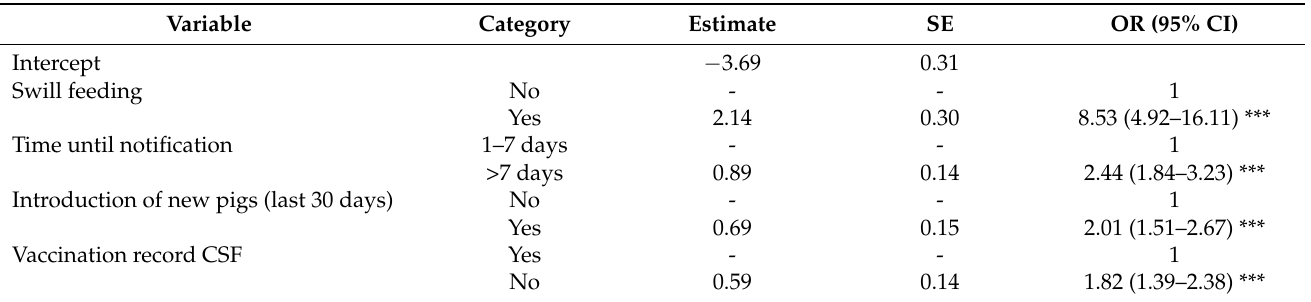
Table 4. Multivariable logistic regression model assessing the association of variables with the odds of CSF between 2014 and 2020 in Ecuador.